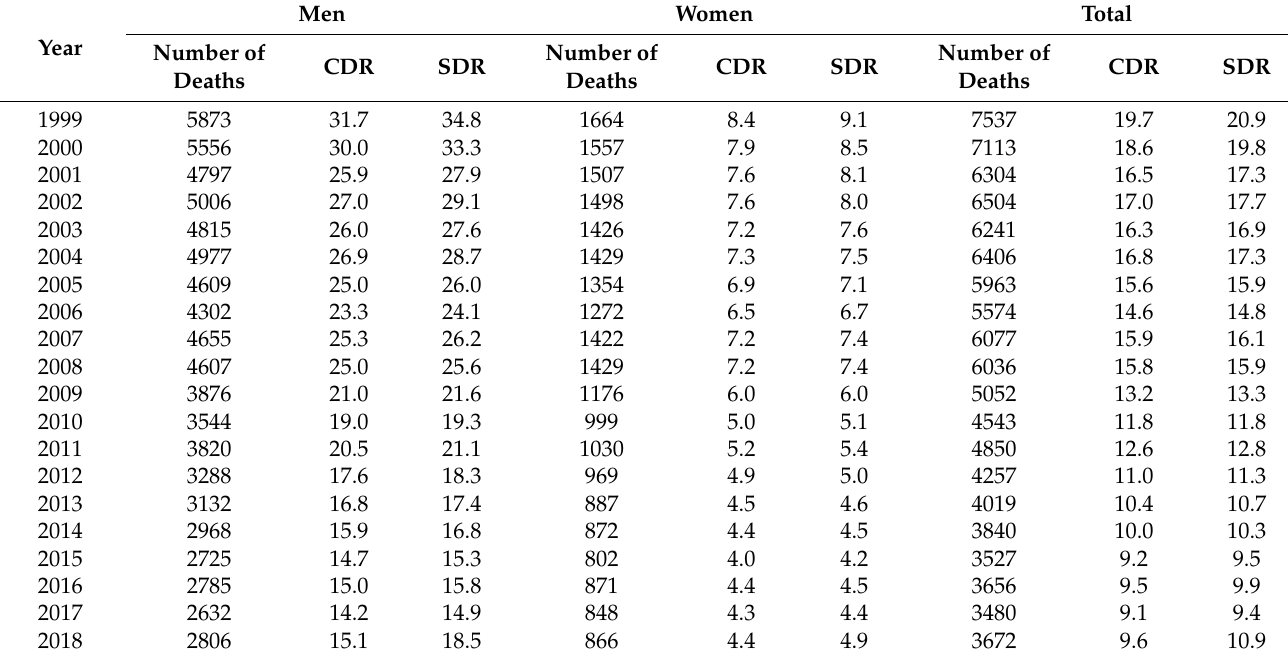
Table 1. Number of deaths and values of CDR (per 100,000) and SDR (per 100,000) due to road traffic injuries in Poland, 1999–2018.